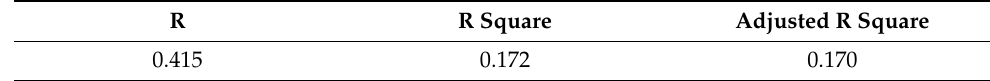
Table 11. Summary of regression